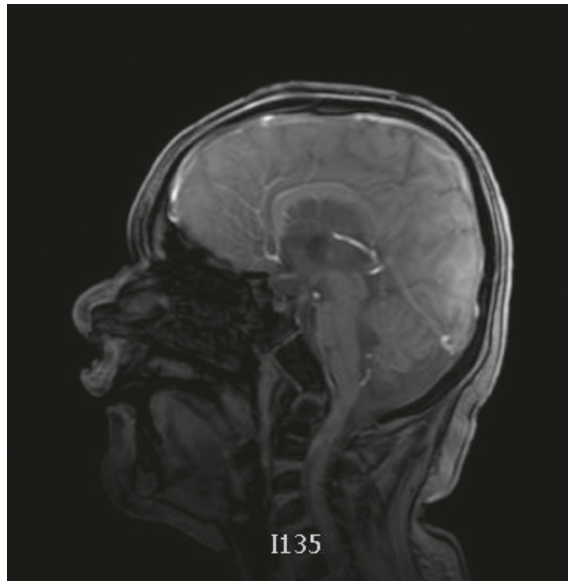
Figure 3: Brain MRI revealing dysgenesis of the corpus callosum, partially empty sella, and third ventricular